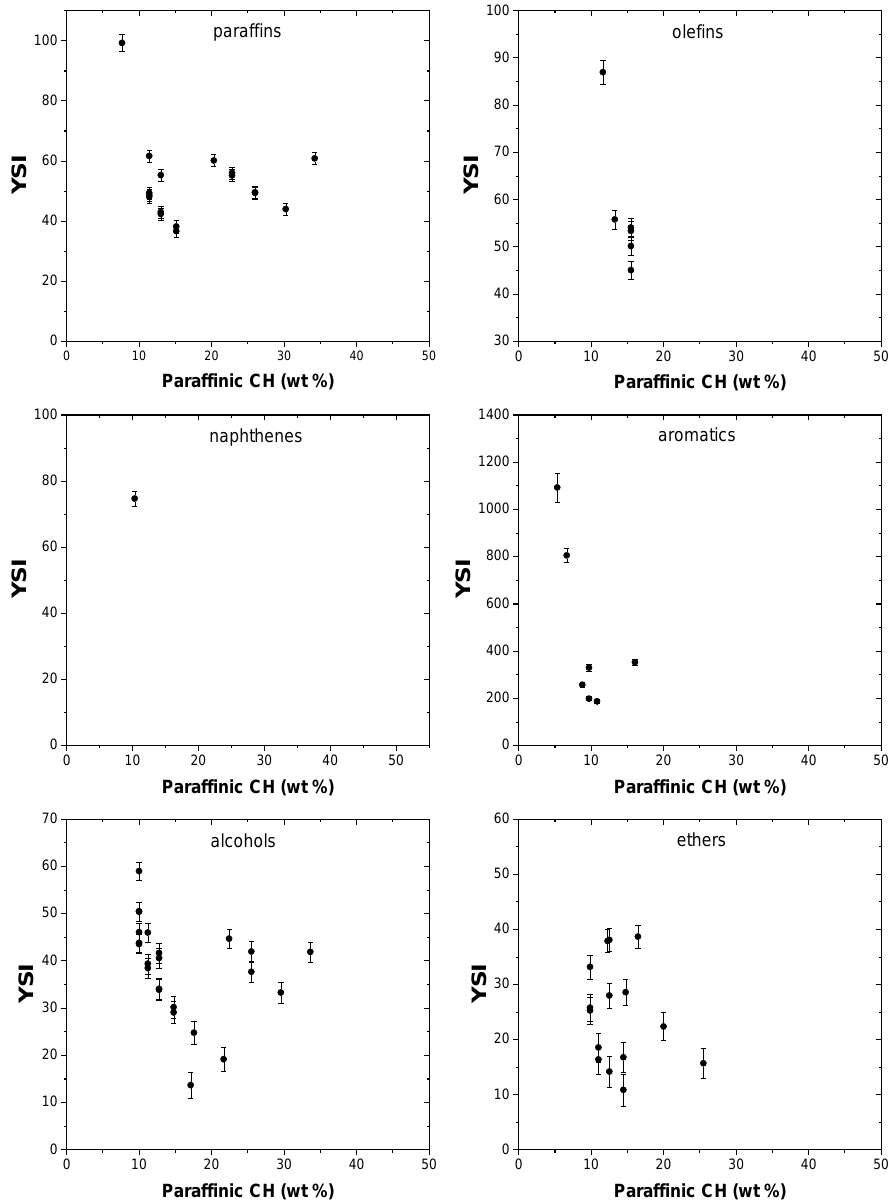
Figure 5. Effect of paraffinic CH groups on YSI .